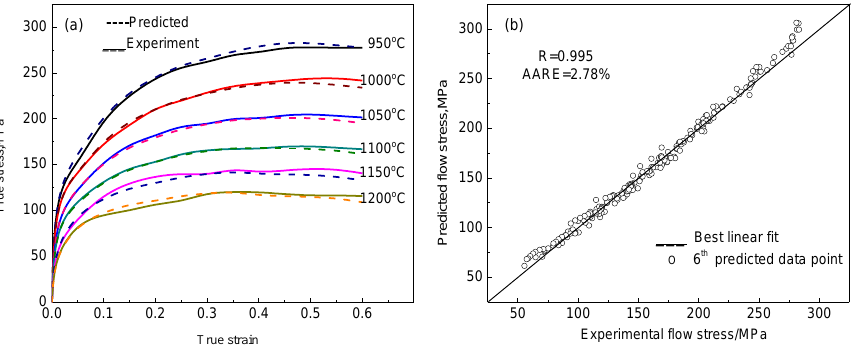
Figure 4. ( a ) Comparisons between predicted and experimental flow stress; ( b ) Correlation between predicted and experimental flow stress.